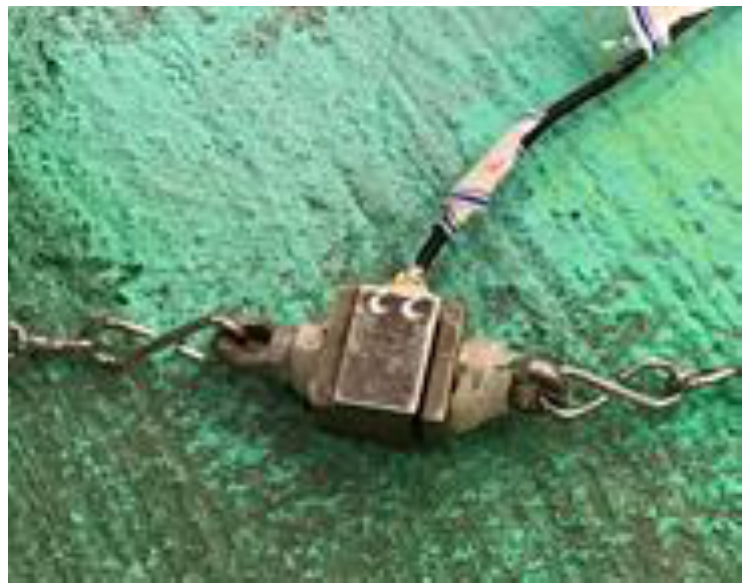
Figure 9. The load cell in the experiment.